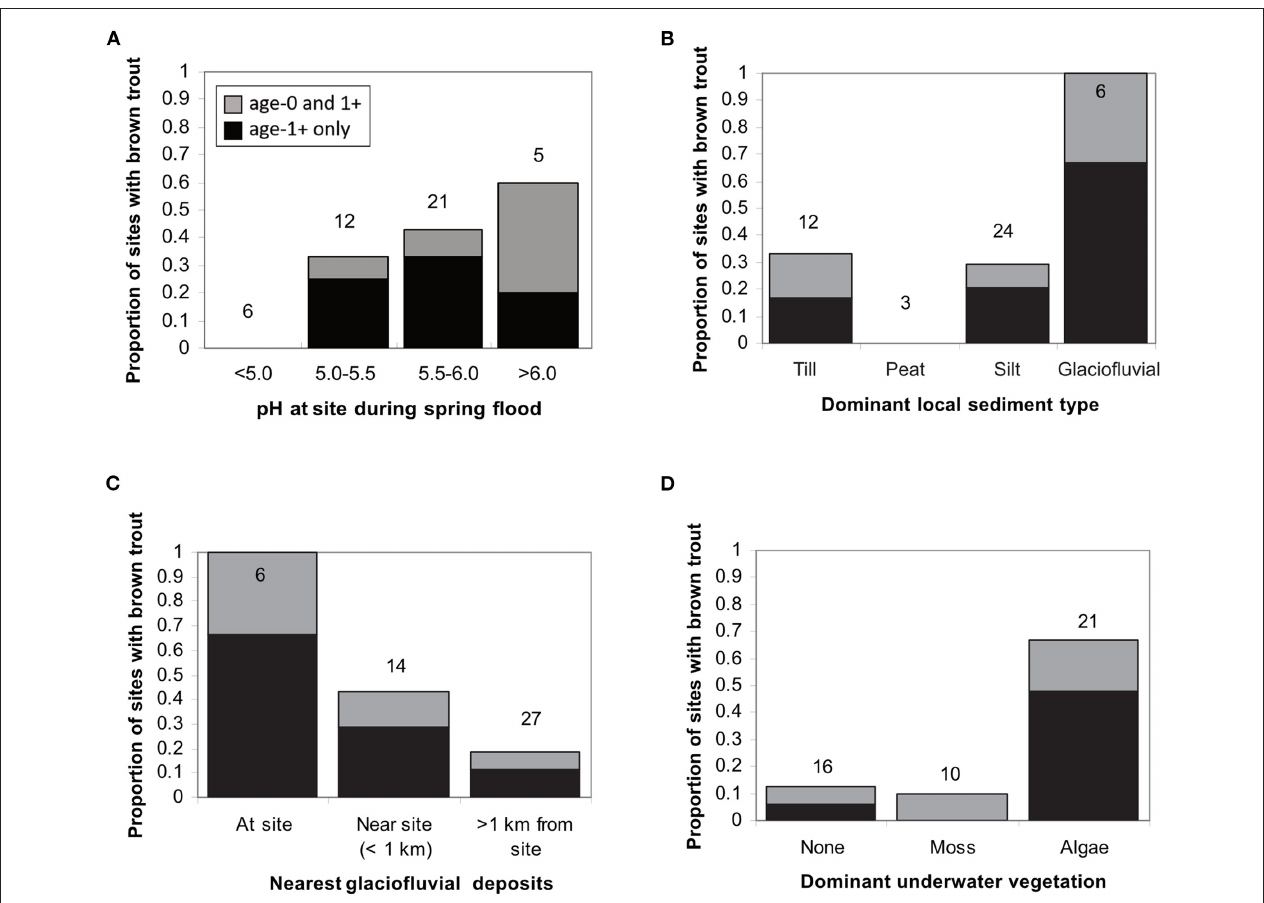
FIGURE 6 | Examples of relationships between individual habitat characteristics and the likelihood of finding brown trout present at a given site. Sites are grouped by: (A) pH at site during spring flood, (B) sediment type at site, (C) distance along stream to nearest surficial glaciofluvial deposit, (D) dominant type of underwater vegetation. Numbers above the bars represent total number of sites in a given